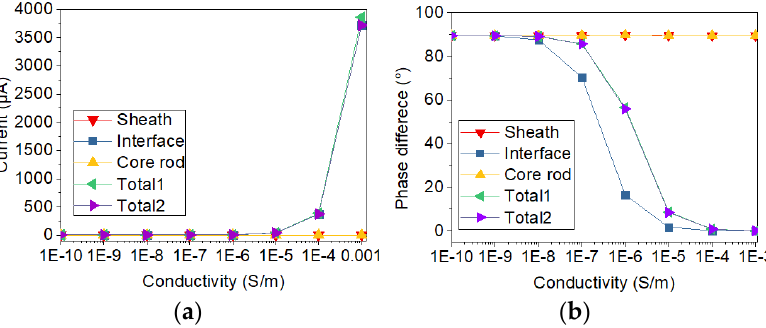
Figure 6. Current varying with conductivity of interface gap: ( a ) Change of current; ( b ) Change of phase difference.